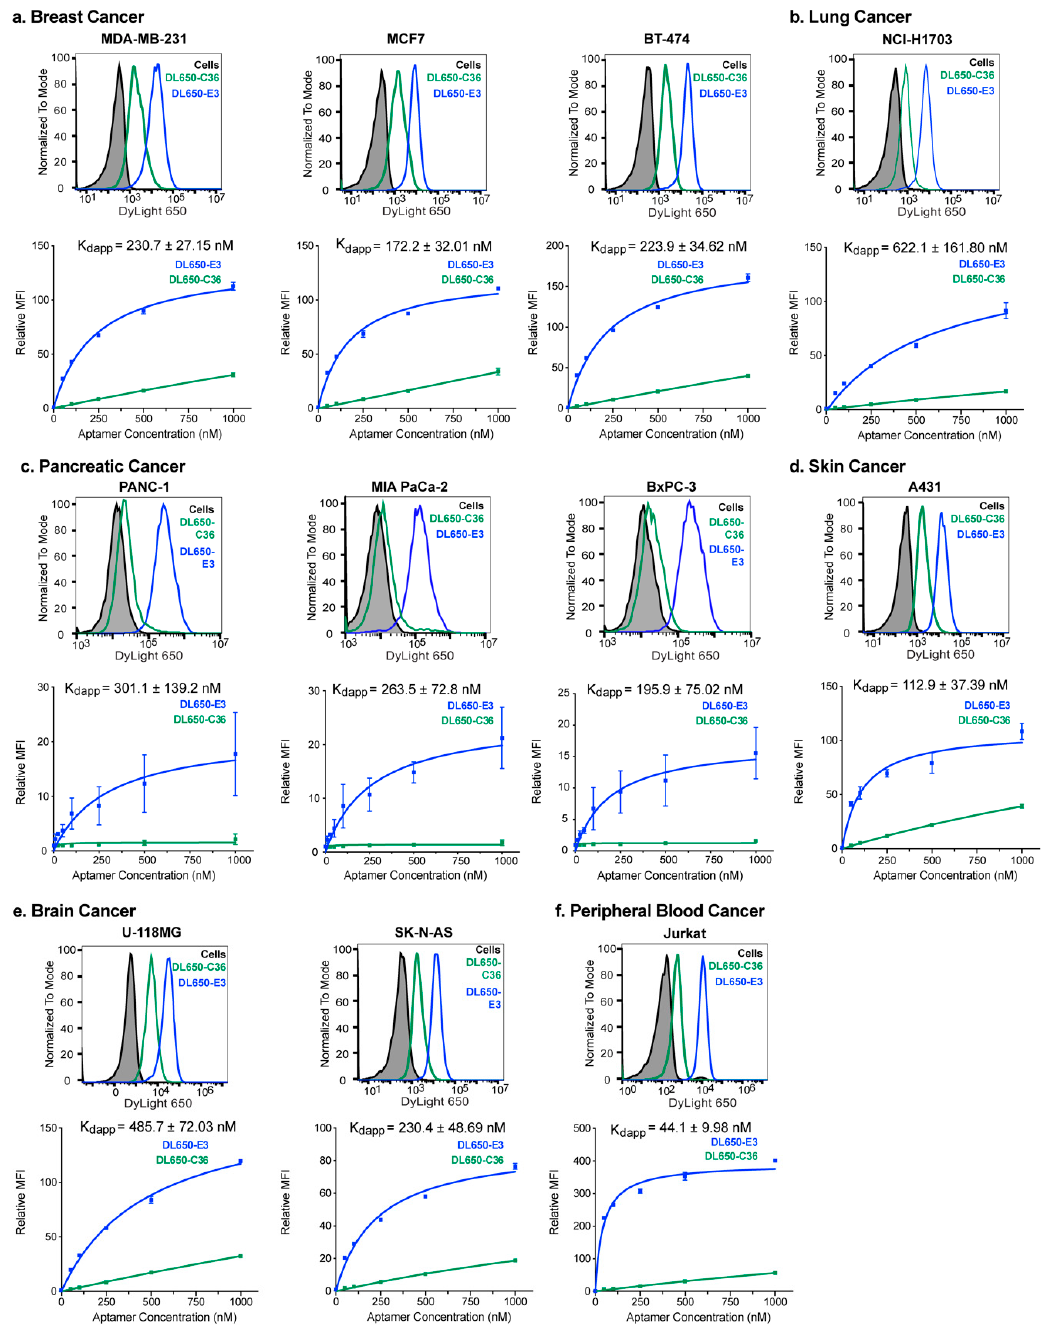
Figure 1. The E3 aptamer targets a broad range of cancer cell types with nanomolar-apparent affinity. Cancer cells were incubated with increasing concentrations of DL650-E3 aptamer or DL650-C36 control aptamer for 1 h before washing cells and analyzing by flow cytometry. The histograms are graphs of cell fluorescence after treatment with the 250 nM ( a,b , d – f ) or 1000 nM ( c ) aptamer solutions, and the binding curves are the combination of three independent experiments, with the median fluorescent intensity (MFI) of the aptamer-treated samples normalized to the median fluorescent intensity of the cells alone signal. Flow cytometry analysis of E3 targeting to ( a ) the breast cancer cell lines MDA-MB-231, MCF7 and BT-474; ( b ) the lung cancer cell line NCI-H1703; ( c ) the pancreatic cancer cell lines PANC-1, MIA PaCa-2 and BxPC-3; ( d ) the skin epidermoid cancer cell A431; ( e ) the brain cancer cell lines U-118MG and SK-N-AS; and ( f ) the Jurkat peripheral blood cancer cell line.